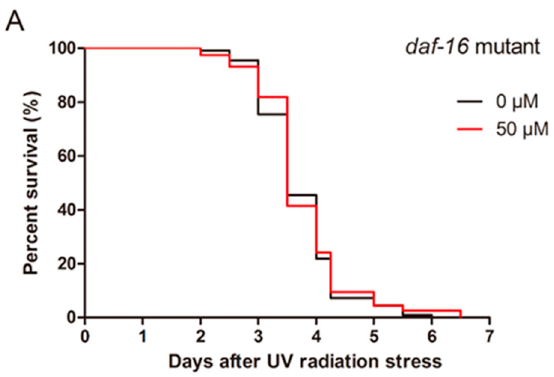
Figure 3. The effects of ellagic acid on the DAF-16 distribution and oxidative indices in the worms exposed to UV radiation. DAF-16 localization in the nucleus of the TJ356 control nematodes ( A ) and the ellagic acid treatment group ( B ) was measured using a fluorescence microscope under 10× objective, n > 15. ( C ) The amount of DAF-16 in the nucleus was calculated using ImageJ software. Each column was represented with the mean ± SD. The SOD-3 expression in the CF1553 worms of the control group ( D ) and the ellagic acid treatment group ( E ) was observed with a fluorescent microscope under a 10× objective, n > 15. ( F ) ImageJ was used to determine the fluorescence intensity of SOD-3 expression in the nematodes. Each column shows the mean ± SD. ( G ) The measurement of the ROS level was achieved by DCFH-DA fluorescence staining, n > 120. ( H ) The SOD activity was determined using a SOD assay kit, n > 500. Each column is represented by the mean ± SD. p < 0.5 (*), p < 0.01 (**), and p < 0.001 (***).